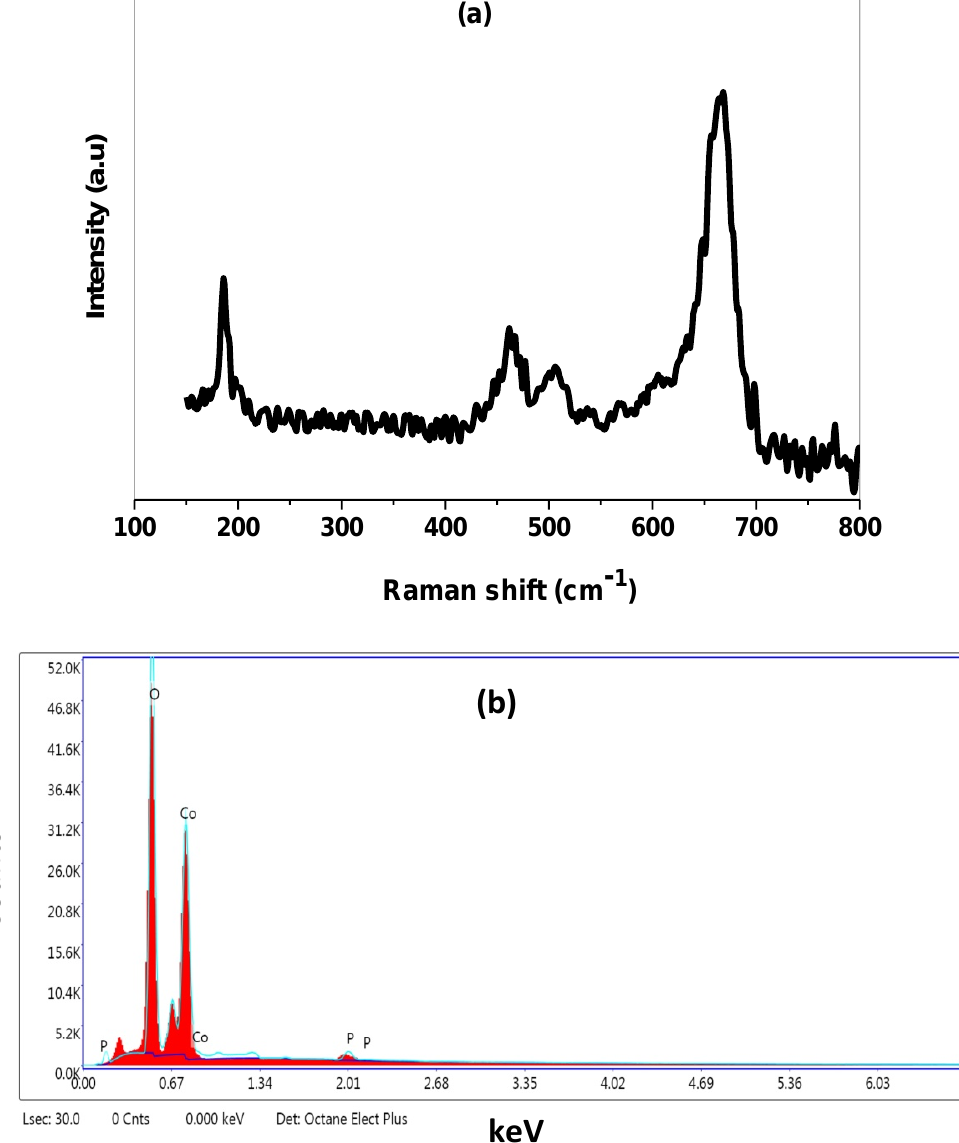
Figure 2. ( a ) Raman spectrum and ( b ) EDX spectrum of Co 3 O 4 nanoparticles.